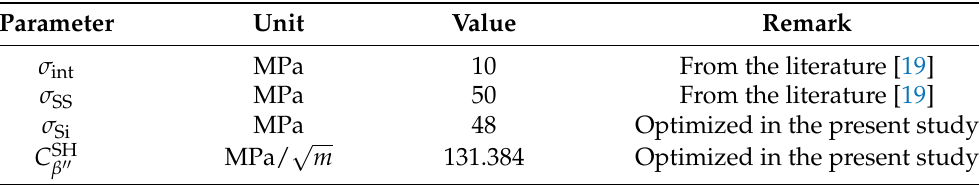
Table 3. Parameters for the yield strength model proposed in the present